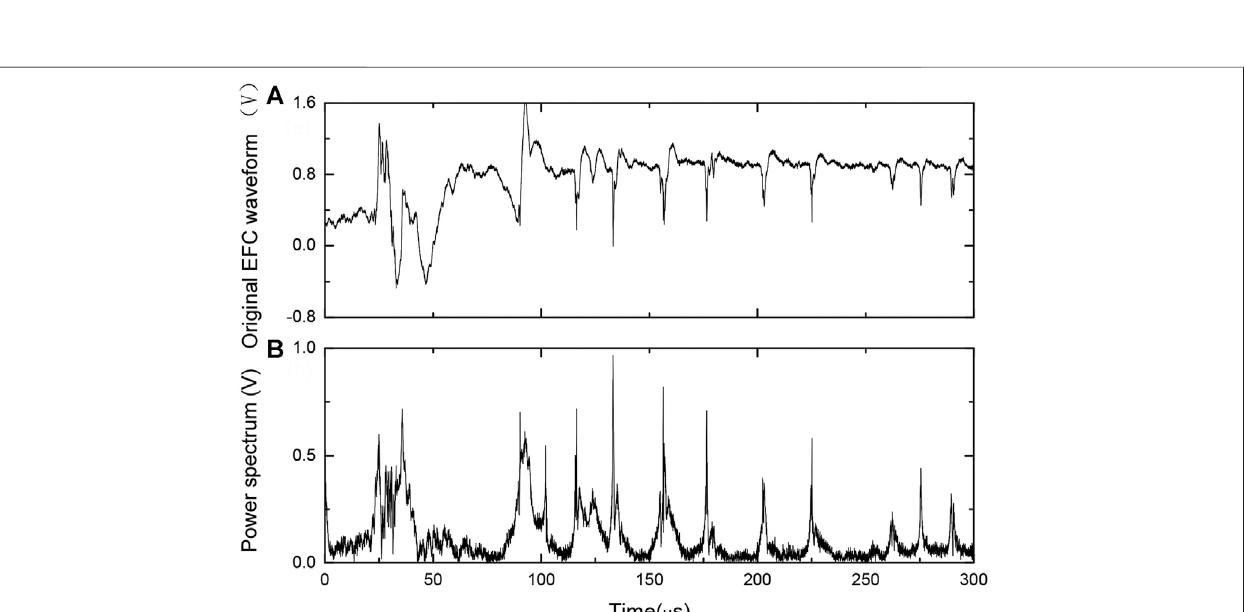
FIGURE 3 | (A) Original VLF/LF radiation waveform. (B) Power waveform.